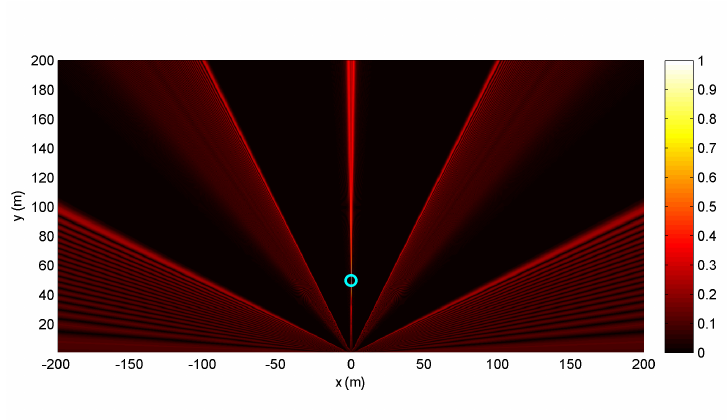
Figure 12. Image map of the correlation coefficient when the first terminals are fixed in the position marked with the circle and the second user is moved on the plane for the 2 λ non-equispaced array with α 1 = −